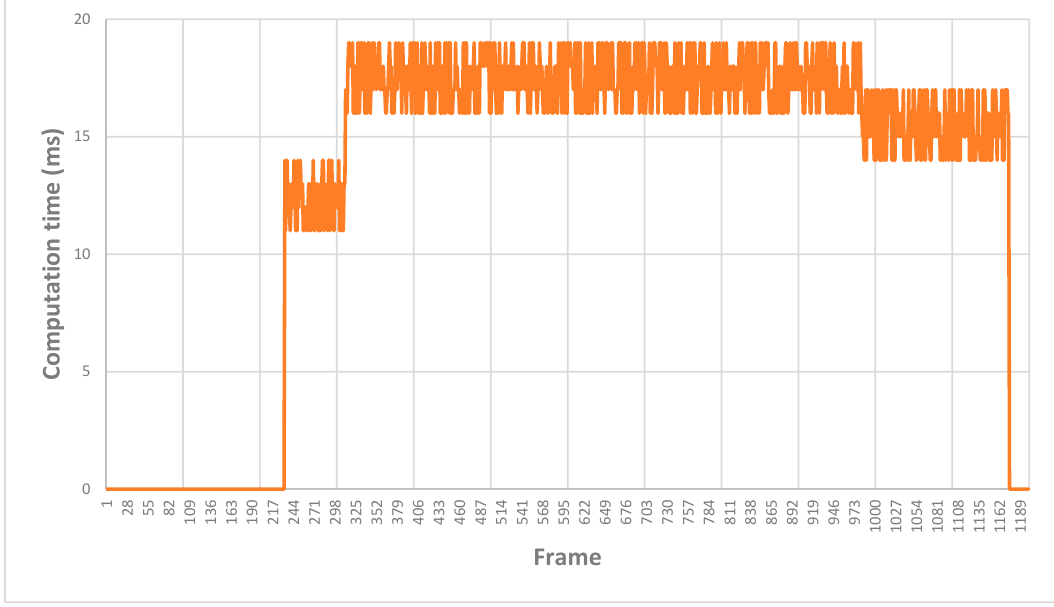
Figure 24. Computation time during landing procedure.